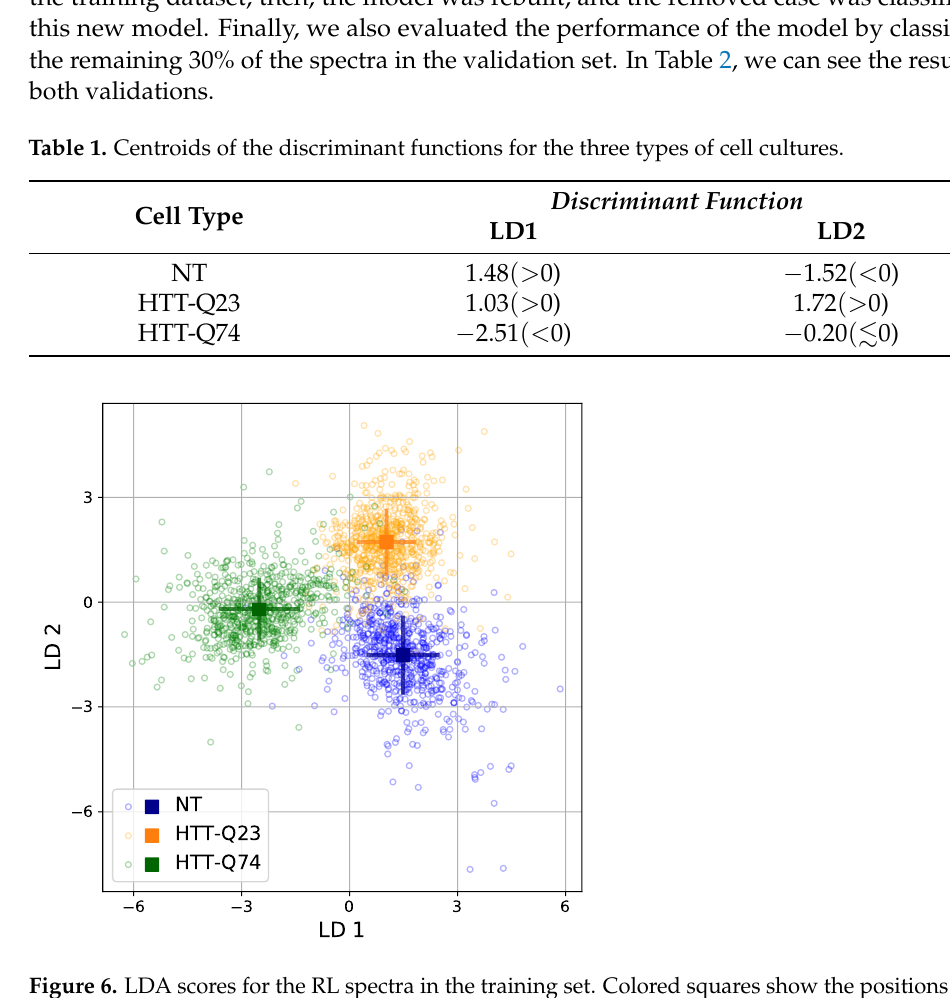
Figure 6. LDA scores for the RL spectra in the training set. Colored squares show the positions of the centroids of each group; the corresponding lines illustrate the standard deviation of the values inside each group. Table 2. Results of the classification and validation of the